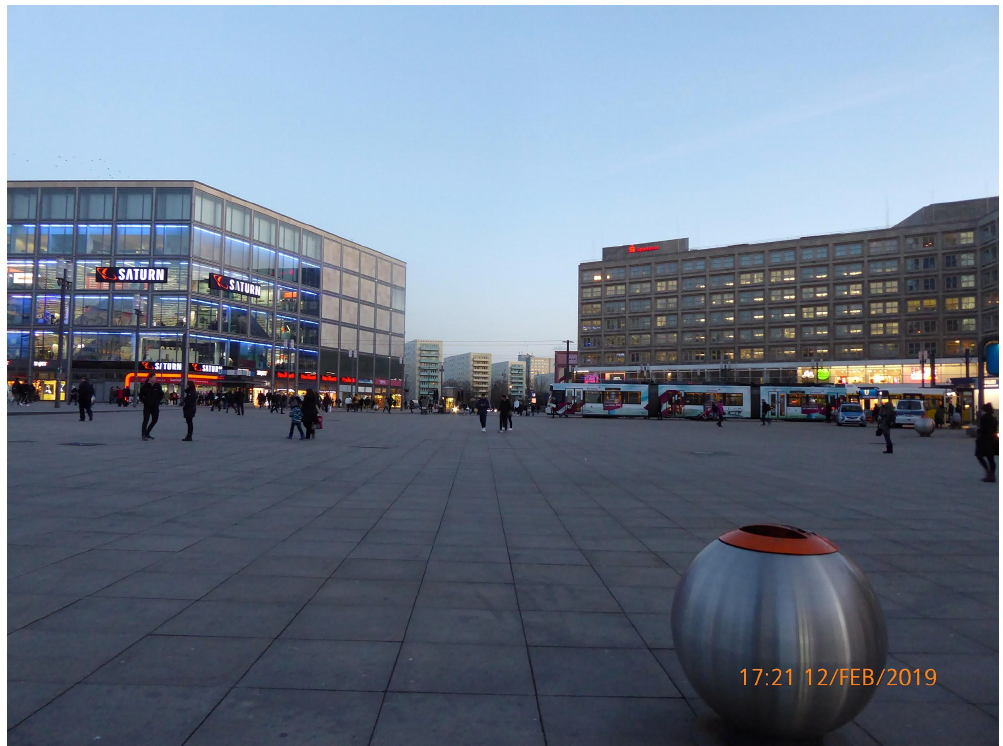
Figure 3. Alexanderplatz. Source: